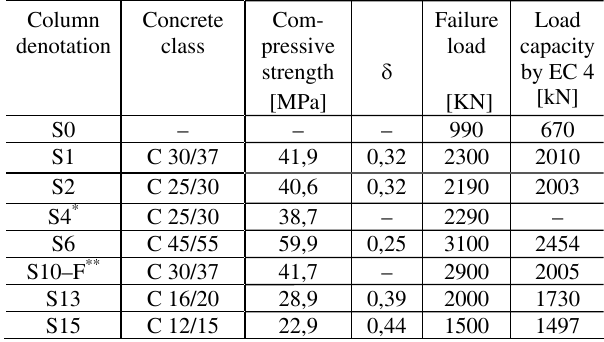
Table 1 . Summary of test results for steel column SO and for selected composite columns